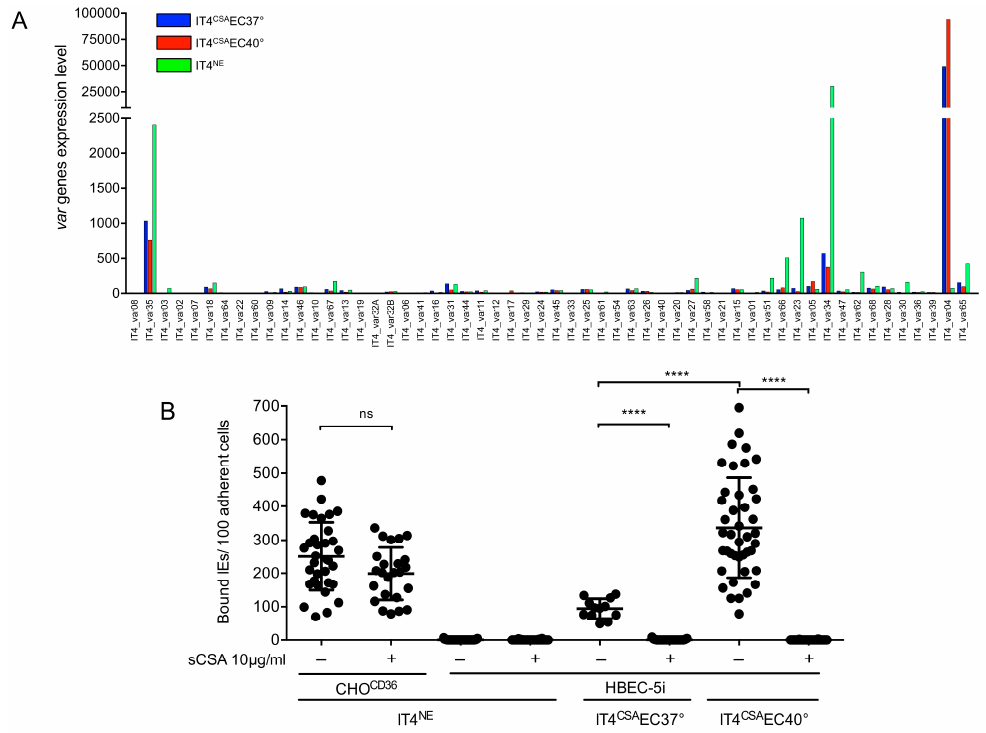
Figure 1. Var expression profile of IT4 populations enriched for binding to HBEC-5i cells at 37 °C and 40 °C, and binding capacity of different IT4 populations to CHO CD36 and HBEC-5i cells. ( A ) Expression profile of all var genes in IT4 populations enriched for binding HBEC-5i cells at 37 °C and 40 °C (IT4 CSA EC37° and IT4 CSA EC40°) in comparison with long-term cultured IT4 parasites (IT4 NE ). The expression level is defined as the average of normalized read counts of four independent transcriptional analyses. ( B ) Binding capacity of IT4 NE to transgenic CHO-475 cells expressing CD36 (CHO CD36 ) and HBEC-5i cells, and of IT4 parasites enriched for binding to HBEC-5i cells at 37 °C and 40 °C (IT4 CSA EC37°, IT4 CSA EC40°). Preincubations of IEs without ( − ) or with (+) 10 µg/mL sCSA is indicated. Each point represents one binding assay. IT4 NE /CHO CD36 : (-) n = 33, (+) n=24; IT4 NE /HBEC-5i: ( − ) n = 42, (+) n = 32; IT4 CSA EC37°/HBEC-5i: ( − ) n = 12, (+) n = 29; IT4 CSA EC40°/HBEC-5i: ( − ) n = 27, (+) n = 36. Statistical significance was assessed by ordinary one-way ANOVA and Tukey’s post hoc test ( ns p > 0.05; **** p < 0.0001).